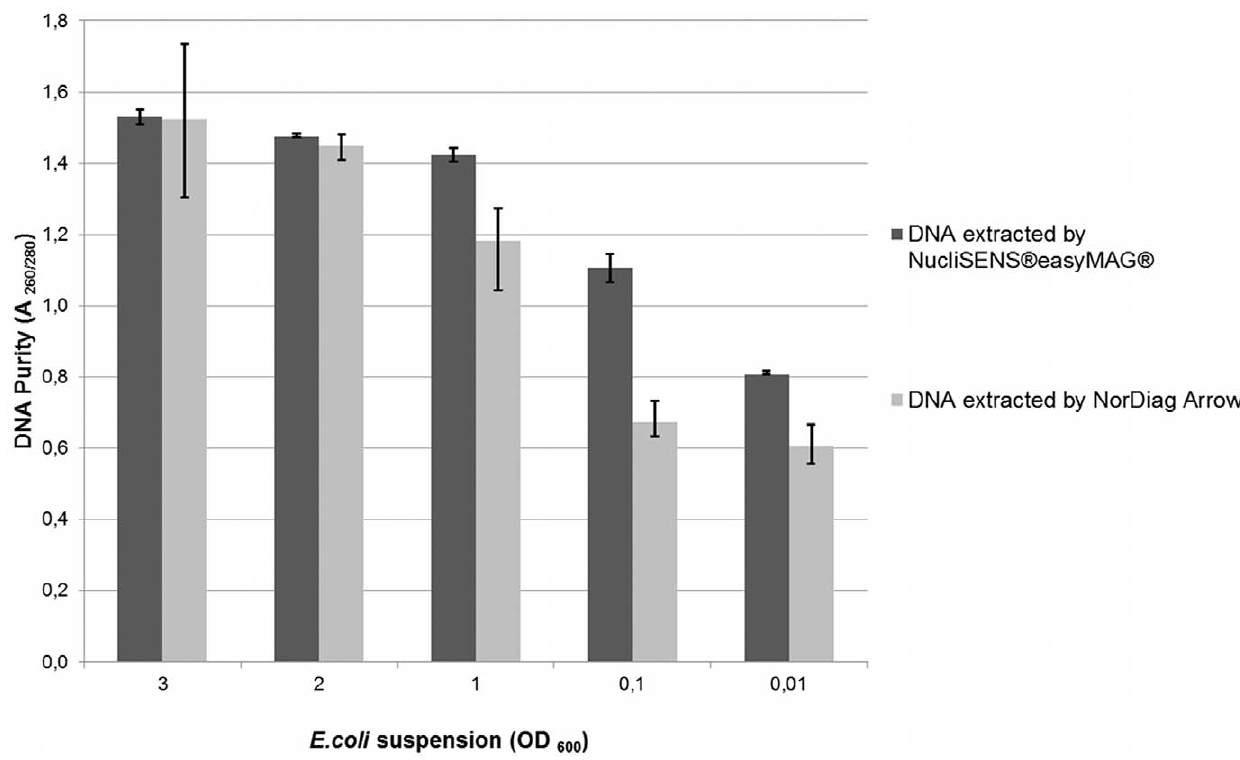
Figure 2. Comparison of the purity (A 260/280 ) of extracted E.coli DNA. Average values and their standard deviations of the three replicated subsamples of E.coli DNA extracts are presented in the columns. Columns are classified by the optical density values (OD 600 ) of the E.coli suspensions measured prior to DNA extraction. Purity of the extracts was determined by a spectrophotometer.